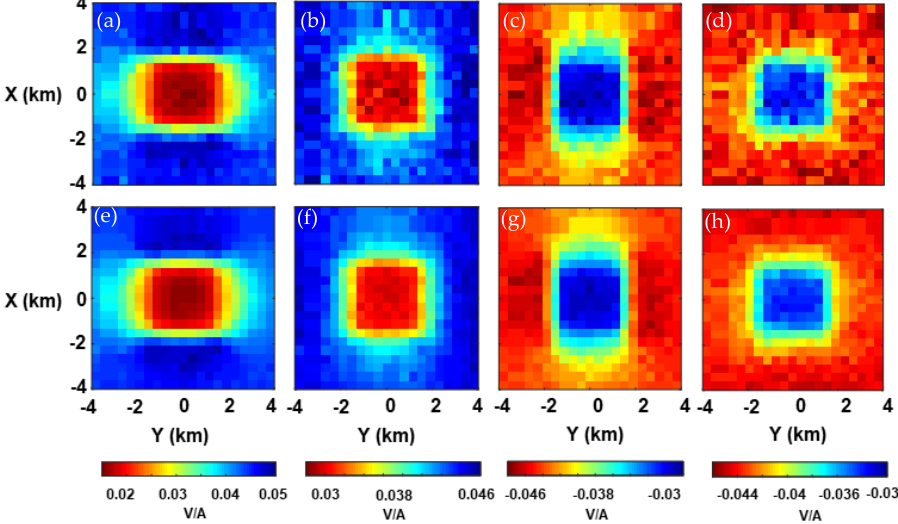
Figure 9. Data fitting of Z xy and Z yx components at the frequency of 5 Hz. Panels ( a ) and ( b ) show the real and imaginary parts of the observed Z xy component. Panels ( c ) and ( d ) show the real and imaginary parts of the observed Z yx component. Panels ( e ) and ( f ) show the real and imaginary parts of the predicted Z xy component. Panels ( g ) and ( h ) show the real and imaginary parts of predicted Z yx component.